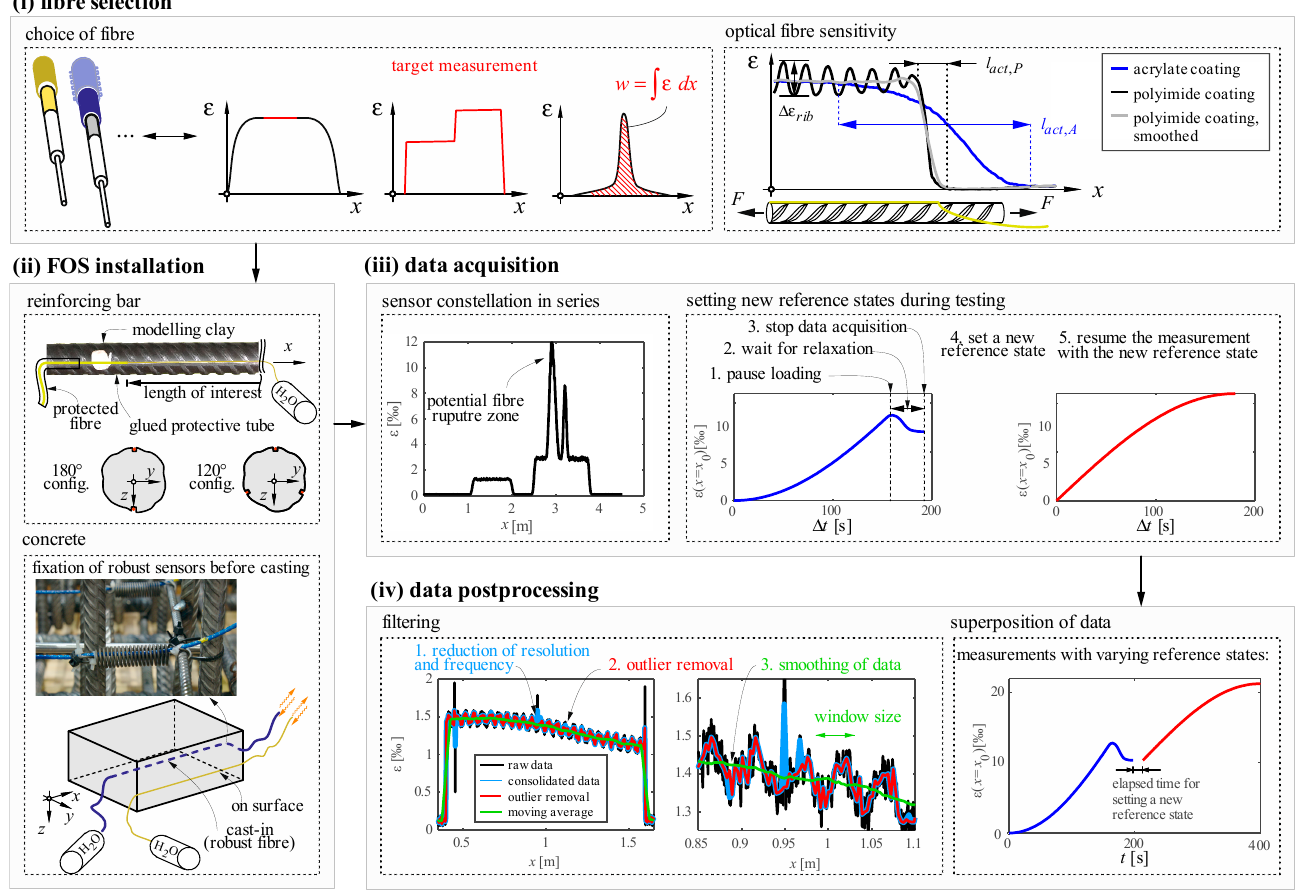
Figure 2. Workflow for fibre optical strain measurement on steel and concrete comprising the following steps: ( i ) Fibre selection, ( ii ) installation on the host material, ( iii ), data acquisition and ( iv ) data post-processing.